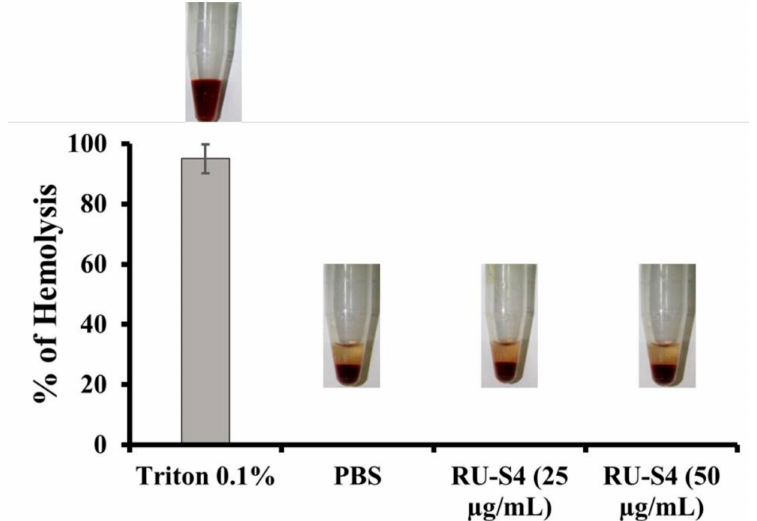
Figure 6. Percentage of hemolysis of blood cells treated with RU-S4 in a blood